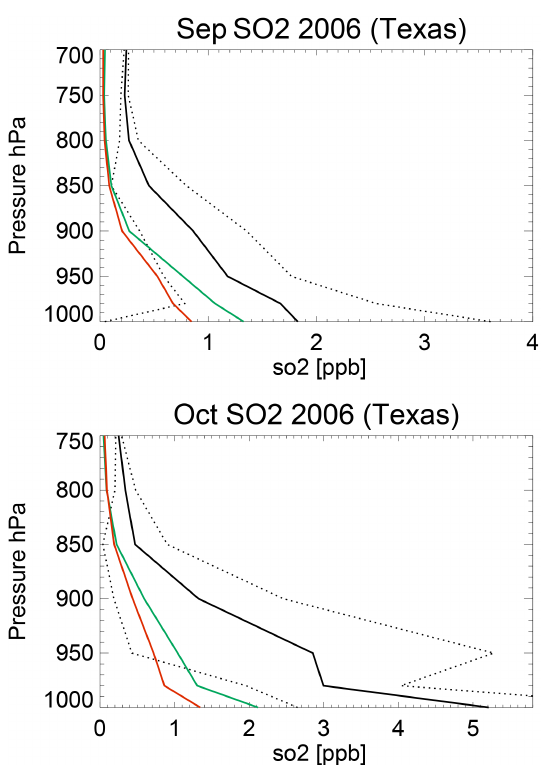
Figure 13. Comparisons of the monthly tropospheric SO 2 profile assembled from data taken during September and October 2006 as part of TexAQS II. The 1 σ deviation of the mean derived from the measurements is shown as the dotted line. For details of the flight paths the reader is referred to Parrish et al.